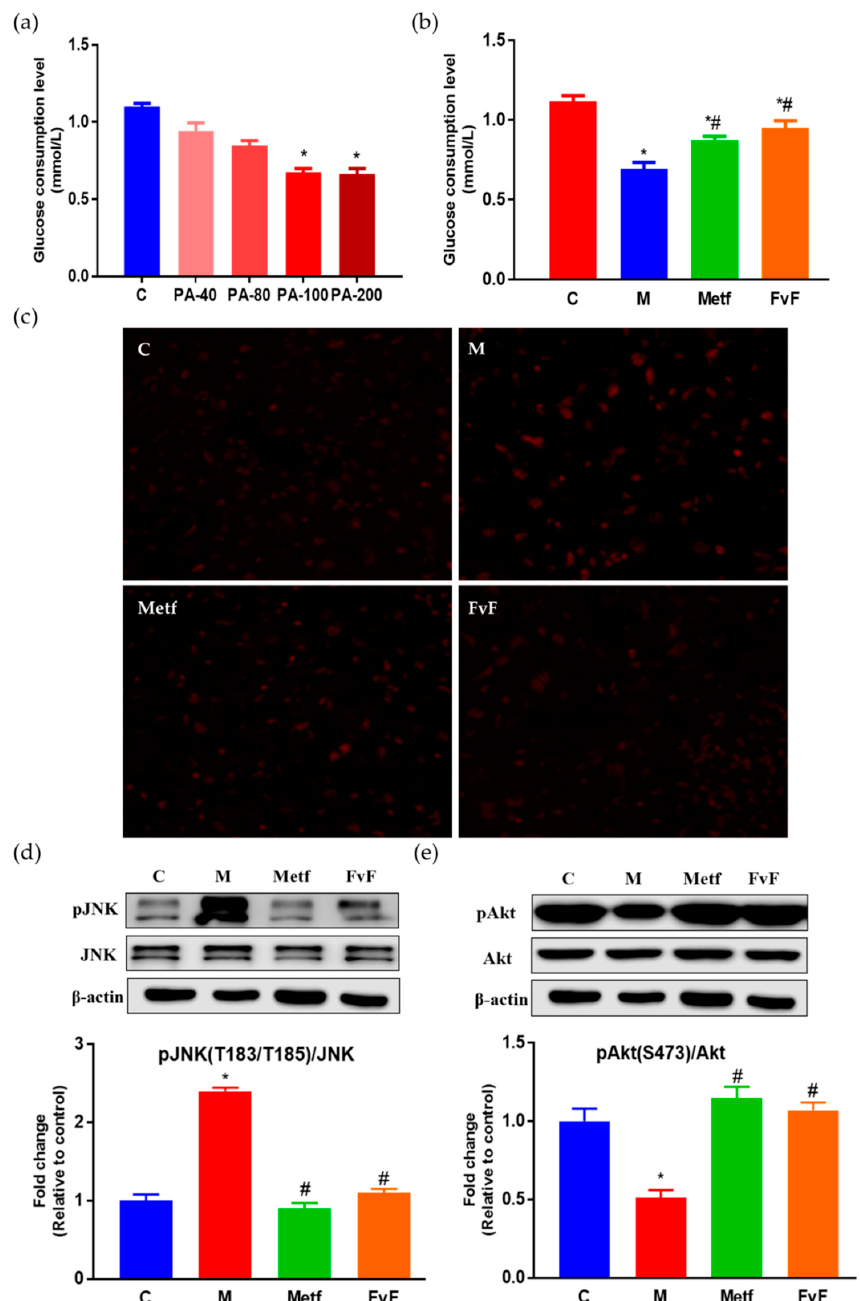
Figure 1. Effects of fucoidan from Fucus vesiculosus (FvF) on relieving insulin resistance (IR) in HepG2 cells. Effects of sodium palmitate (PA) on cellular glucose consumption ( a ). Cells were treated with a concentration range of PA for 24 h. Effects of FvF on glucose consumption in IR cells ( b ). Cells were treated with Metf (2 mM) or FvF (100 μ g/mL) in the presence of 100 μ M PA for 24 h. ( c ). Reactive oxygen species (ROS) was detected by in situ dihydroethidium (DHE) staining (200×). C, control group; M, cells were treated with 100 μ M PA for 24 h; Metf and FvF, cells were treated with metformin (2 mM) or FvF (100 μ g/mL) in the presence of 100 μ M PA for 24 h. Phosphorylation of c-Jun N-terminal kinase (pJNK) ( d ) and phosphorylation of protein kinase B (pAkt) ( e ) protein levels changed between different treatment groups. C, control group; M, cells treated with 100 μ M PA for 24 h; Metf and FvF, cells treated with 100 μ M PA for 24 h then incubated with metformin (2 mM) or FvF (100 μ g/mL) for another 6 h. Data are expressed as the mean ± SEM. Differences were assessed by ANOVAs and statistical results are denoted as follows: * p < 0.05 versus the control group; # p < 0.05 versus the model group.